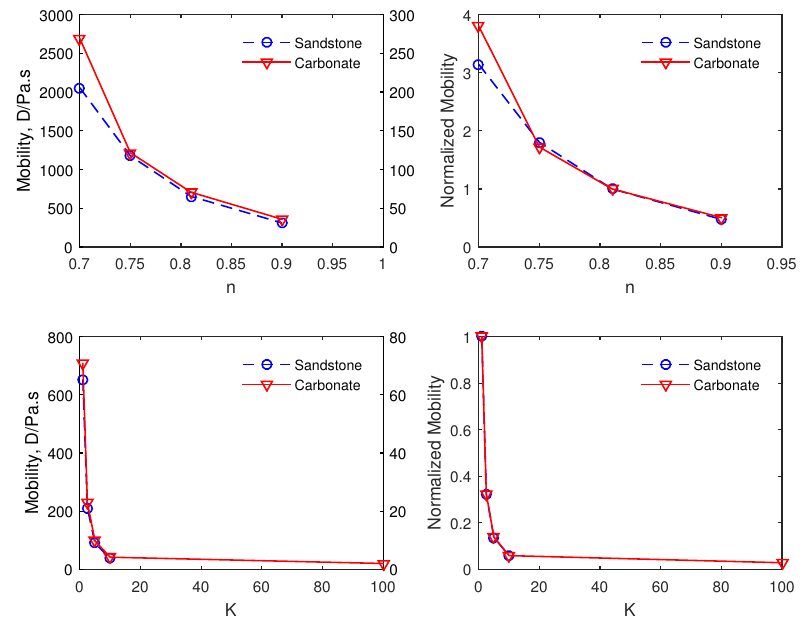
Figure 10. The sensitivity of the effective mobility to (top) the flow behavior index n and (bottom) the consistency factor (K) at a temperature of 300K and 200ppm of the polymer concentration. The effective mobility is being normalized with that of water as detailed in Section 2.